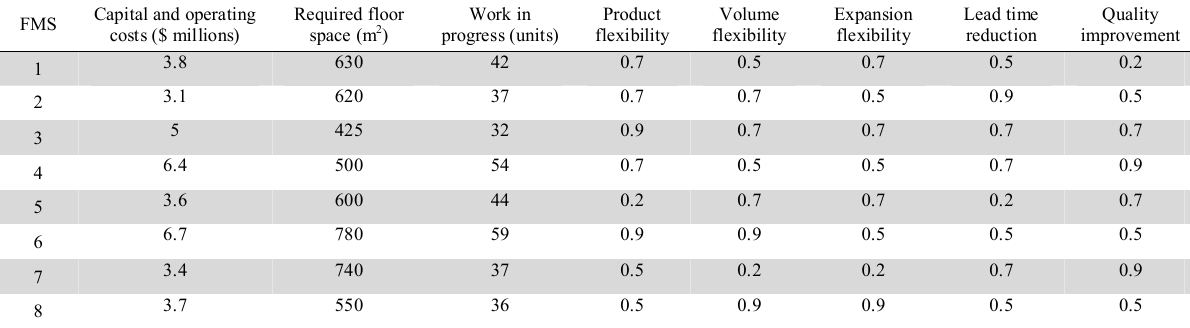
Quantitative data for the FMS selection problem (Karsak, 2002)